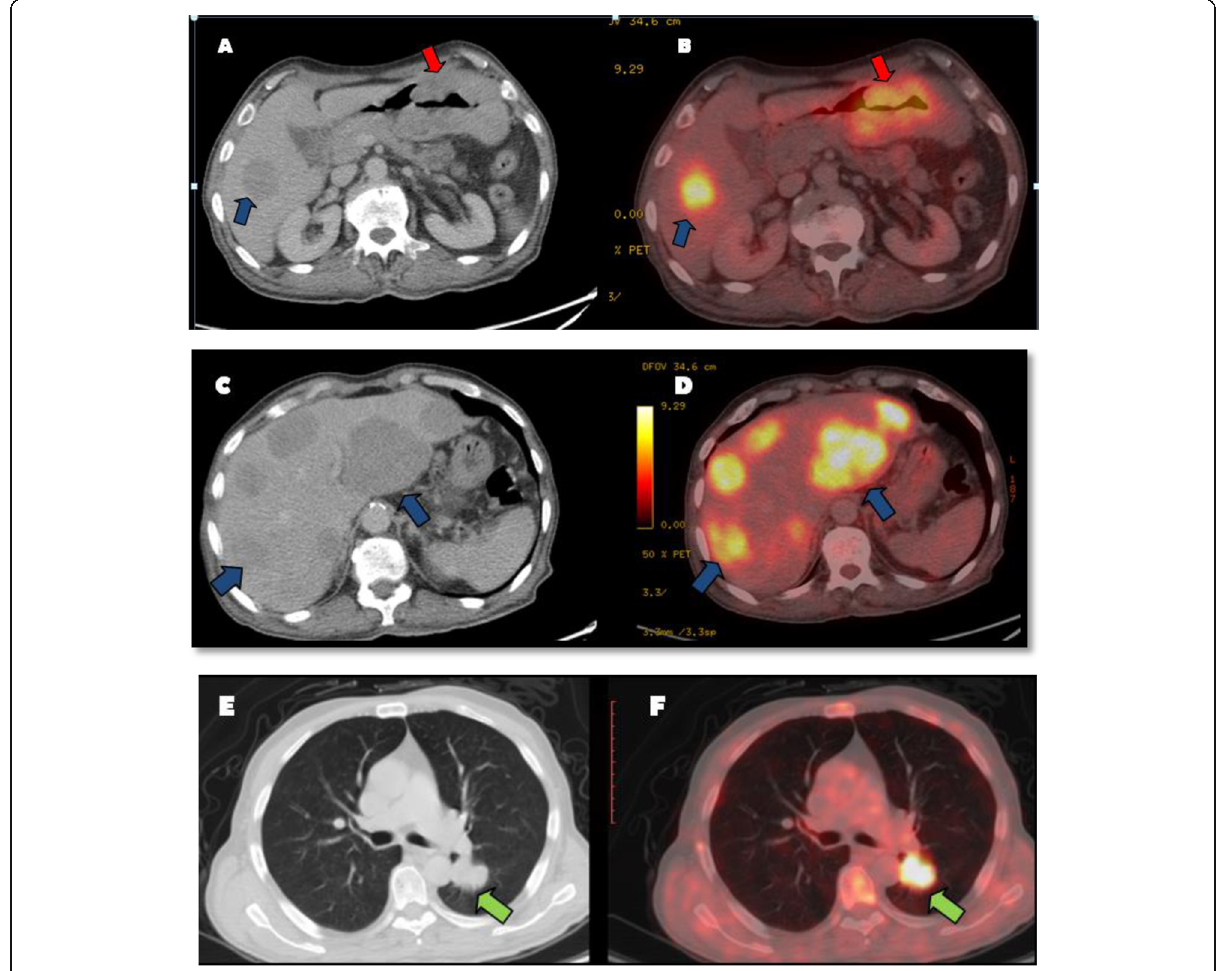
Fig. 1 Axial post-contrast CT and fused PET/CT images for a 70-year-old male patient with a history of gastric cancer and had received chemotherapy. Images a and b showed a metabolically active irregular circumferential polypoidal mural thickening involving the gastric body and antrum region (red arrows), measuring 25mm in its maximum thickness with SUVmax ~ 6.3. Images a – d showed multiple metabolically active hypodense metastatic hepatic focal lesions (blue arrows) scattered in both hepatic lobes; the largest is seen in the left hepatic lobe measuring 6.5 cm in its maximum dimension with SUVmax ~ 12.5. Images e and f showed a metabolically active left lower lobe apical segment perihilar region metastatic soft tissue mass lesion (green arrows) measuring 3.2cm with SUVmax ~